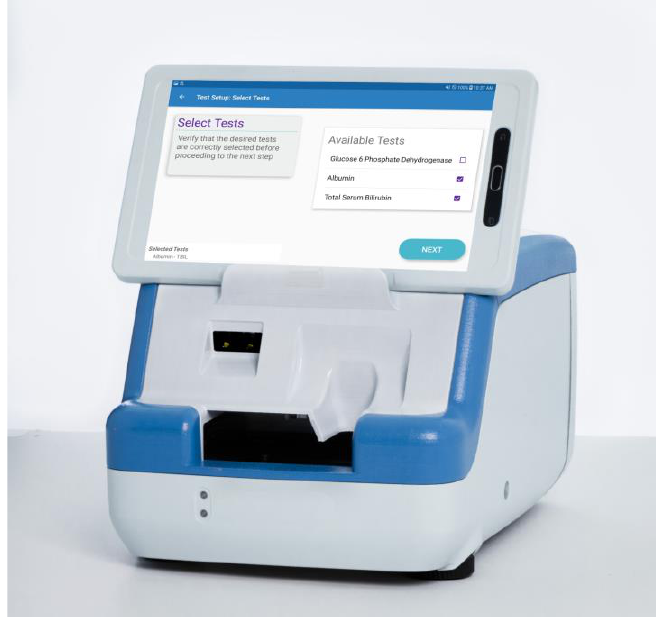
Figure 1. Rendering of the main components of the digital microfluidic instrument.